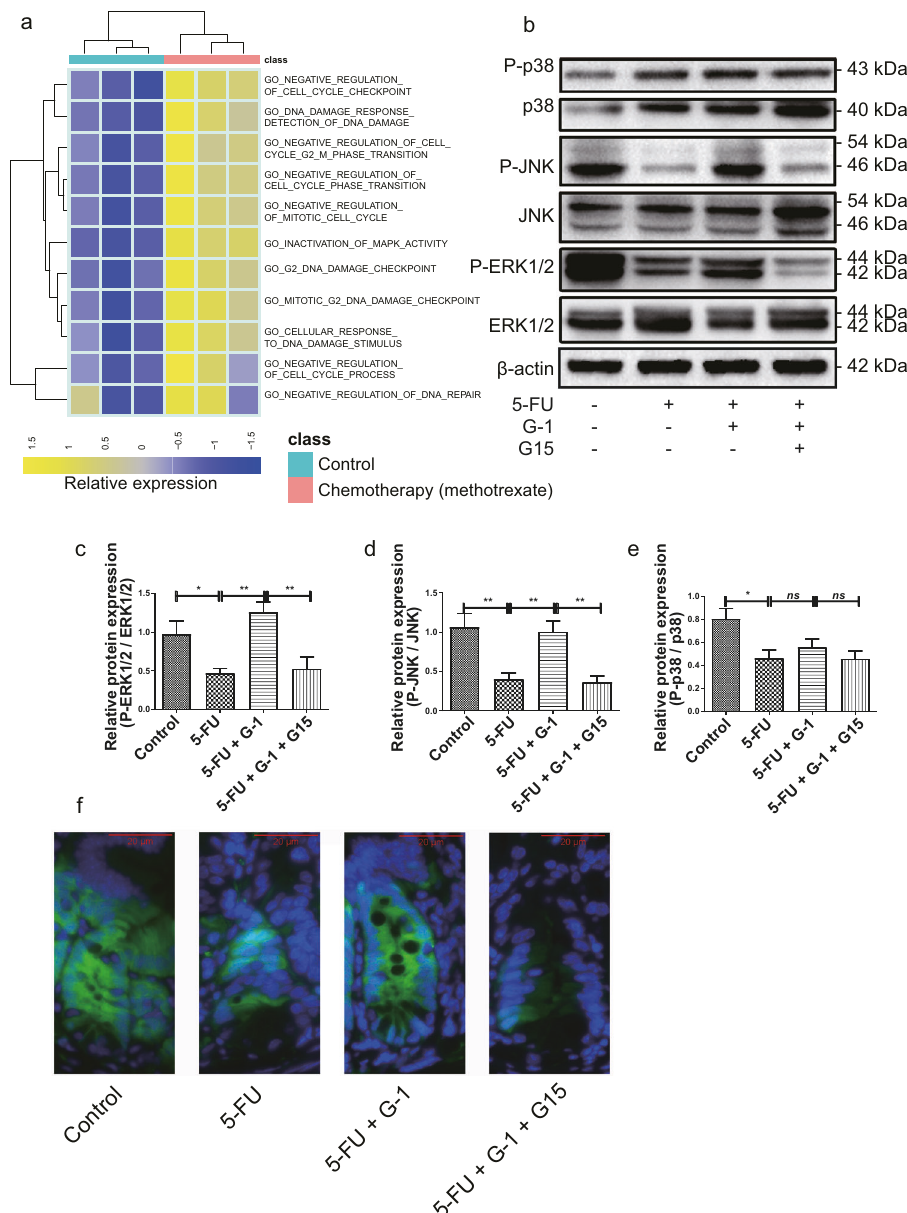
Fig. 6 Effect of GPER activation on ERK1/2 activity in the CIM model. CIM model was induced by i.p. injection 5-FU (30 mg/kg/day) for 5 days. G-1 (0.03 mg/kg/day) and/or G15 (0.3 mg/kg/day) were administrated intraperitoneally with 5-FU together. G-1 was administrated alone or with G15 together in the CIM model to test the effect of GPER activation. On the 5 th day, the ileum was collected for immuno fl uorescence staining and western blot. Data were expressed as mean ± SEM ( * P < 0.05, ** P < 0.01). a The GSVA analysis showed that MAPK signaling pathway was inactivated under the chemotherapeutic drug methotrexate treatment, with the enhancement of DNA damage and cell cycle arrest. b Representative western blots photographs for MAPK signal pathway from the control group and from the 5-FU treated group with or without G-1, G15 application. c Statistical analysis of P-ERK1/2 within four subgroups to show the effect of GPER activation on the activity of ERK1/2 in the CIM model ( n = 5). d Statistical analysis of P-JNK within four subgroups to show the effect of GPER activation on the activity of JNK in the CIM model ( n = 5). e Statistical analysis of P-p38 within four subgroups to show the effect of GPER activation on the activity of p38 in the CIM model ( n = 5). f Immuno fl uorescence staining for P-ERK1/2 in ileum from the control group and from the 5-FU treated group with or without G-1, G15 application (Scale bars: 20 μ improvement in proliferation might be the key reasons why crypt depth in CIM model was restored by GPER activation. G15 GPER inhibits intestinal mucositis. abolished the effects of G-1 on apoptosis and proliferation of The levels of cyclins and their spatiotemporal localization have crypt cells. Following blocking endogenous GPER activation been suggested as crucial determinants of cell fate. Cyclin D1 and with G15, 5-FU-induced apoptosis was signi fi cantly aggravated, B1 promote the transformation of G1 → S phase and G2 → M and increasing of injury as observed by certain parameters, phase in the cell cycle respectively. Decreasing the expression of such as weight loss and histological damage, further suggest- cyclin D1 and B1 was related with the dysfunction of cell cycle ing the role of GPER in CIM. This inhibition of apoptosis and